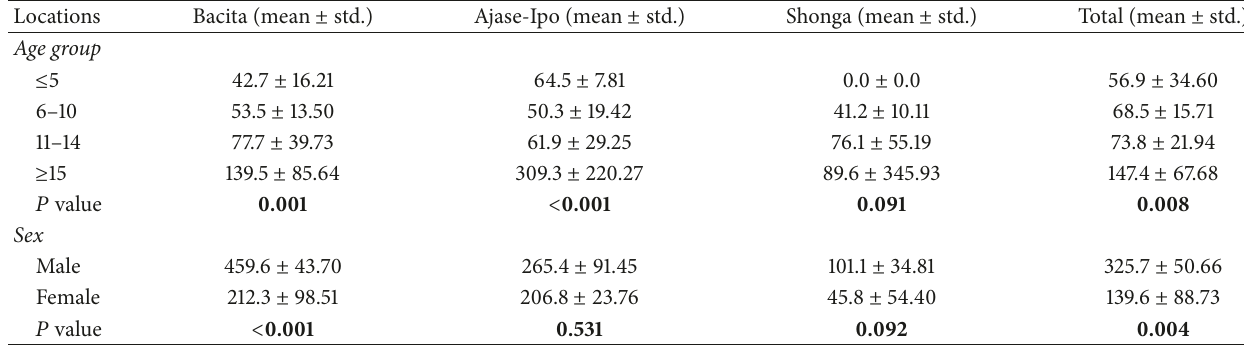
Table 3: Egg counts of the S. haematobium in 10ml of urine of the infected study populations.